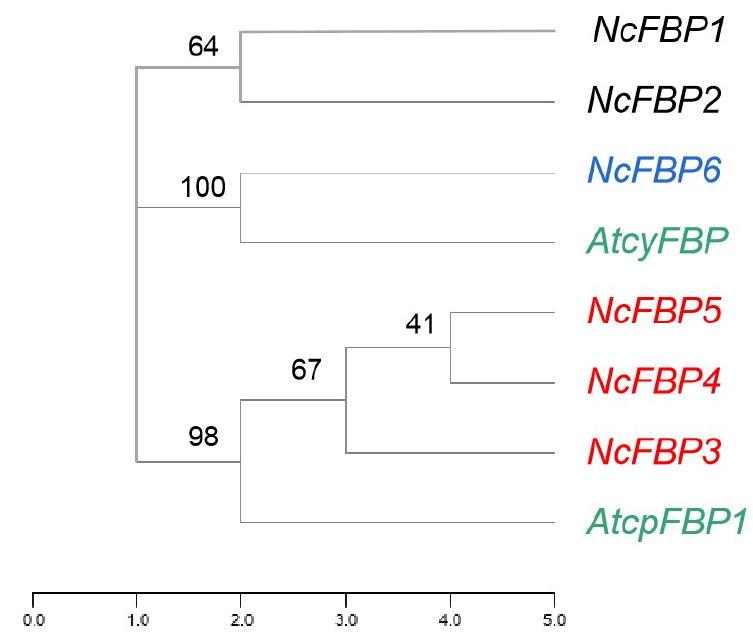
Figure 2. Evolutionary Analysis of FBP homologous genes between N. cadamba and A. thaliana . The AtcyFBP and AtcyFBP1 represent the cytoplasmic FBP and the chloroplast FBP1 of A. thaliana , re-